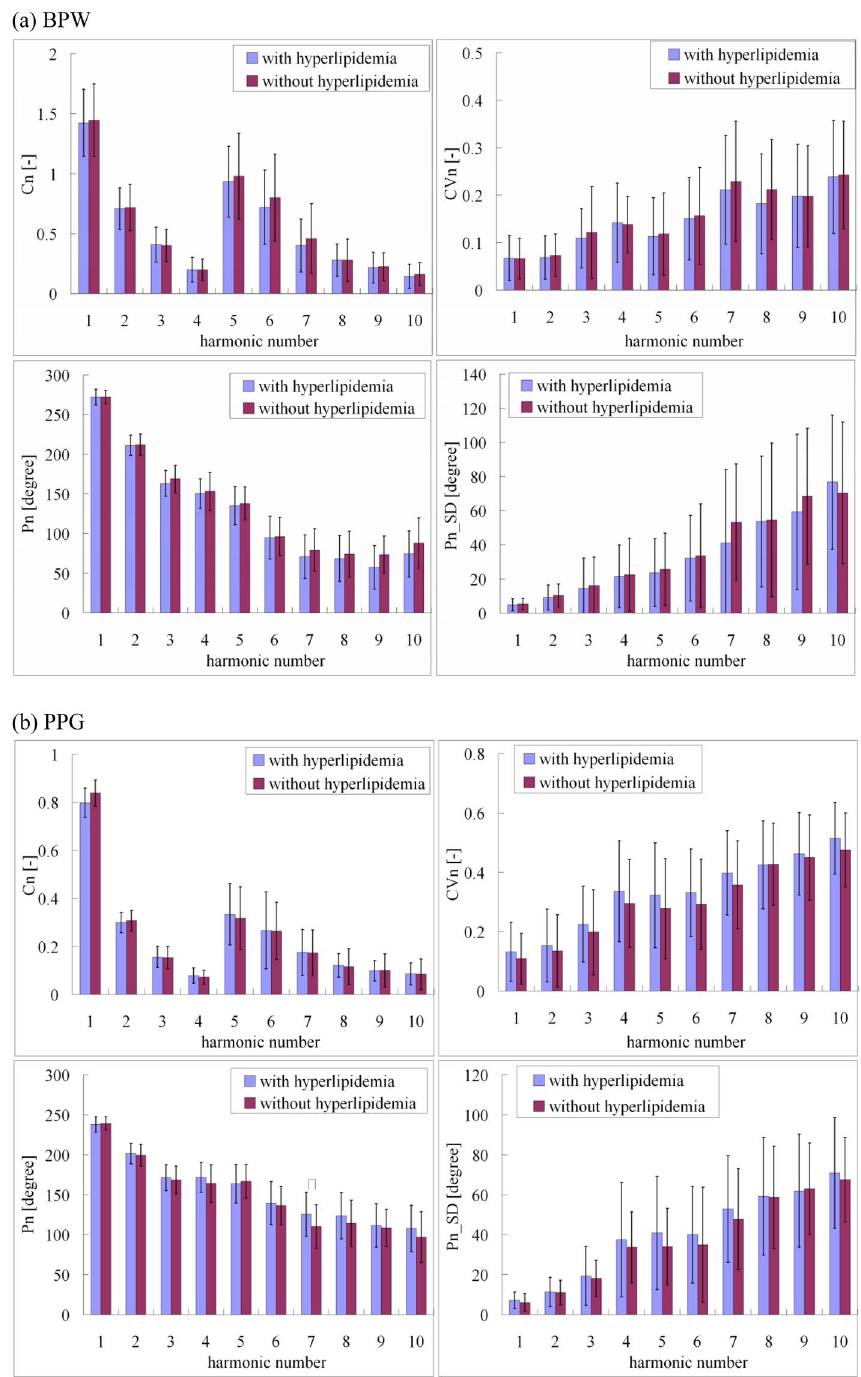
Figure 4. Comparisons of ( a ) BPW and ( b ) PPG harmonic indices between subjects with and without hyperlipidemia: C n , CV n , P n , and P n _ SD . Data are mean and standard-deviation values. C 5 – C 10 values have been multiplied by 5 to make the differences clearer. “ ⌢ ” indicates p < 0.05. None of the BPW pulse indices differed significantly between subjects with and without hyperlipidemia. P 7 was the only PPG pulse index that differed significantly between subjects with and without